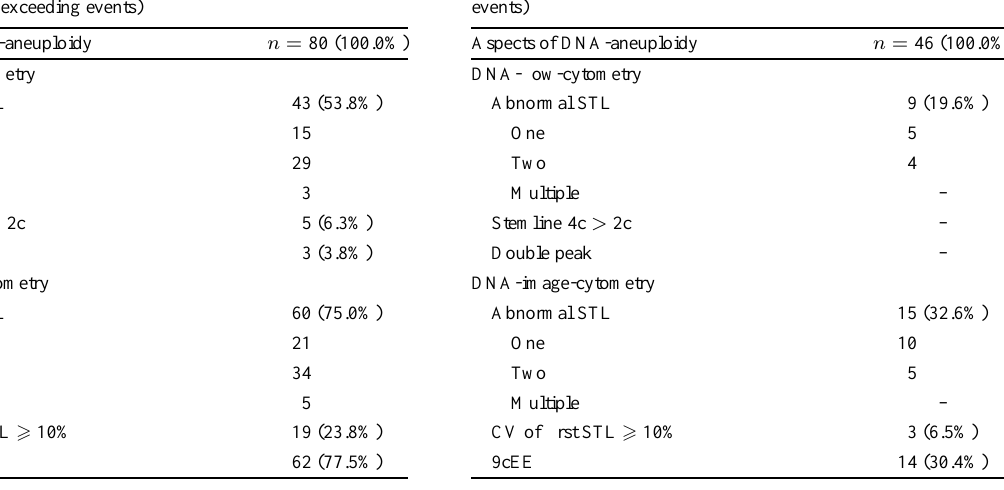
Prevalence of DNA-aneuploidy in cells of cytologically equivocal effusions DNA-ploidy-status Cytologically equivocal effusions DNA-flow-cytometry DNA-image-cytometry DNA-non-aneuploid